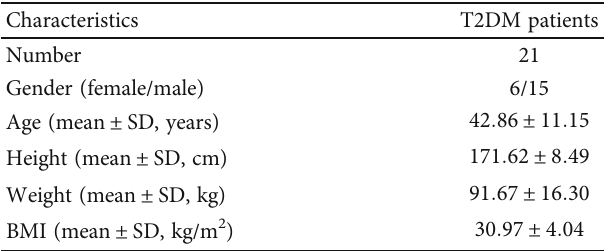
Table 1: Demographic characteristics of T2DM